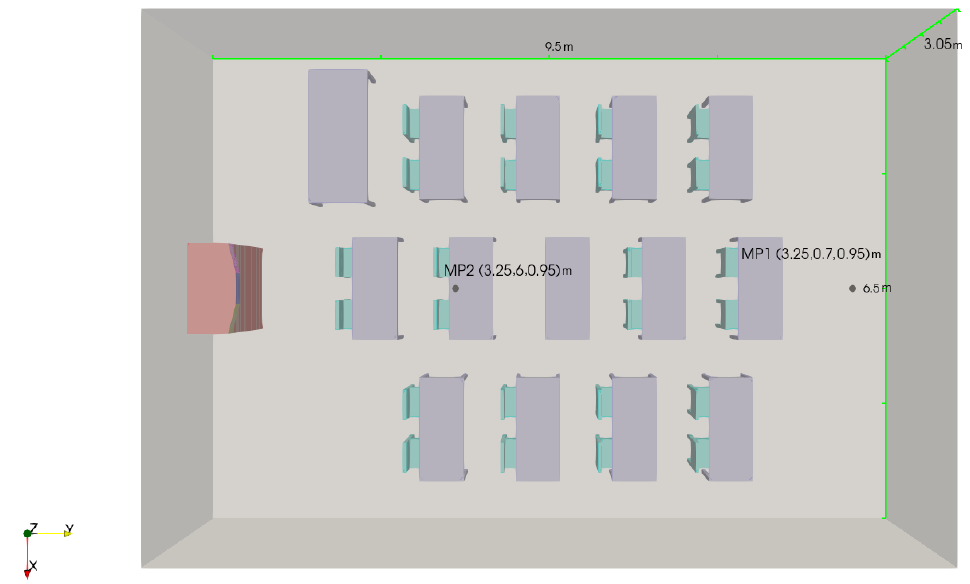
Figure 3. Room setup for validation case showing two measuring